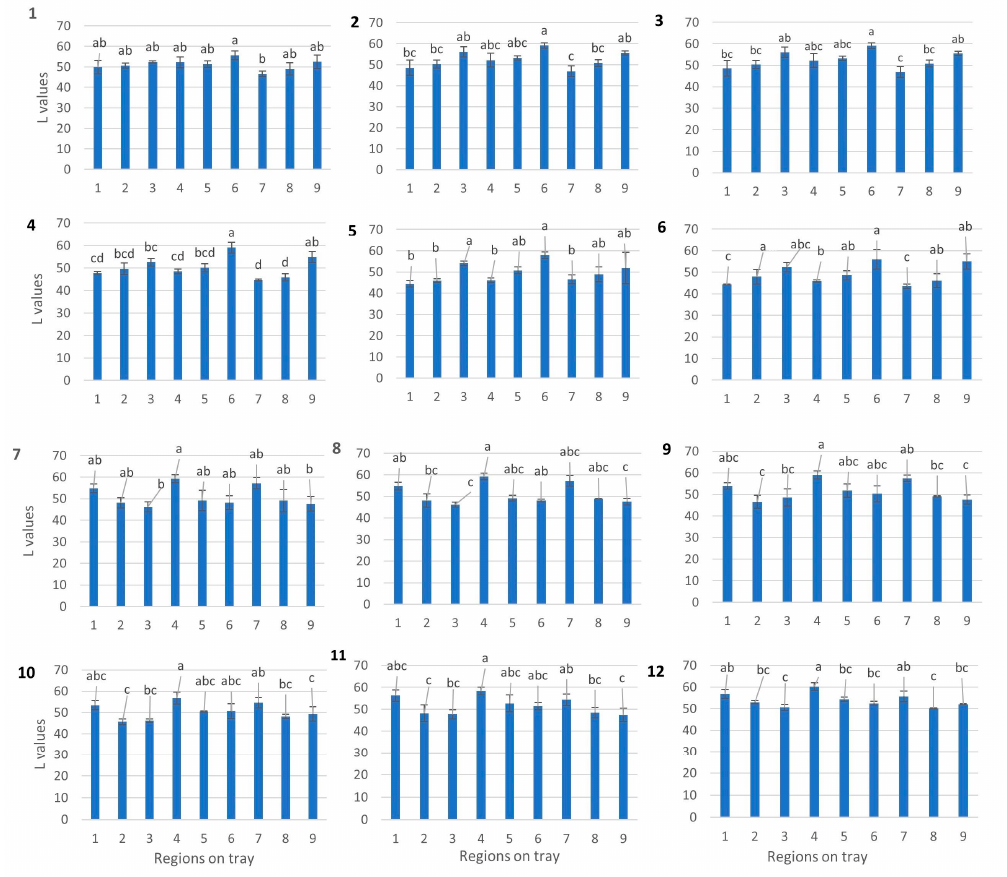
Figure 7. Mid-layer analysis of each tray after processing at 121 °C. Similar letters indicate no significant difference ( p < 0.05).